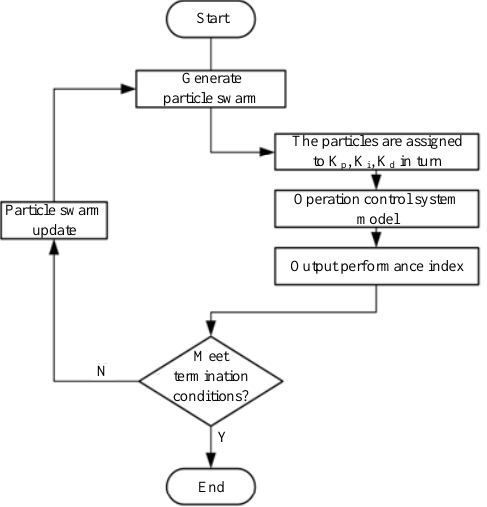
Figure 10. Schematic diagram of PSO PI principal process.